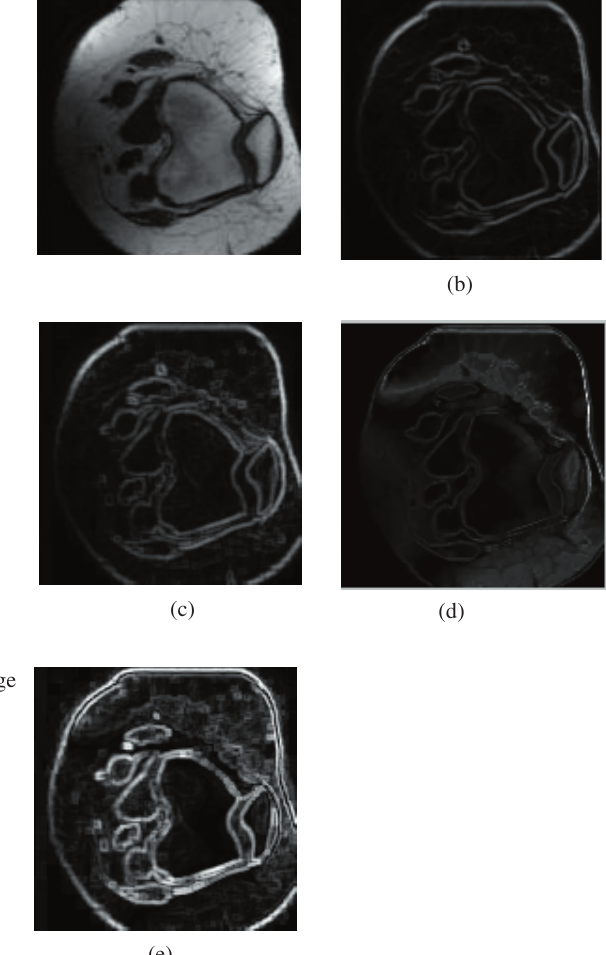
Fig. 3. : a) knee patella image, b) edge image using fuzzy morphology, c) edge image using the interval valued fuzzy set, d) edge image